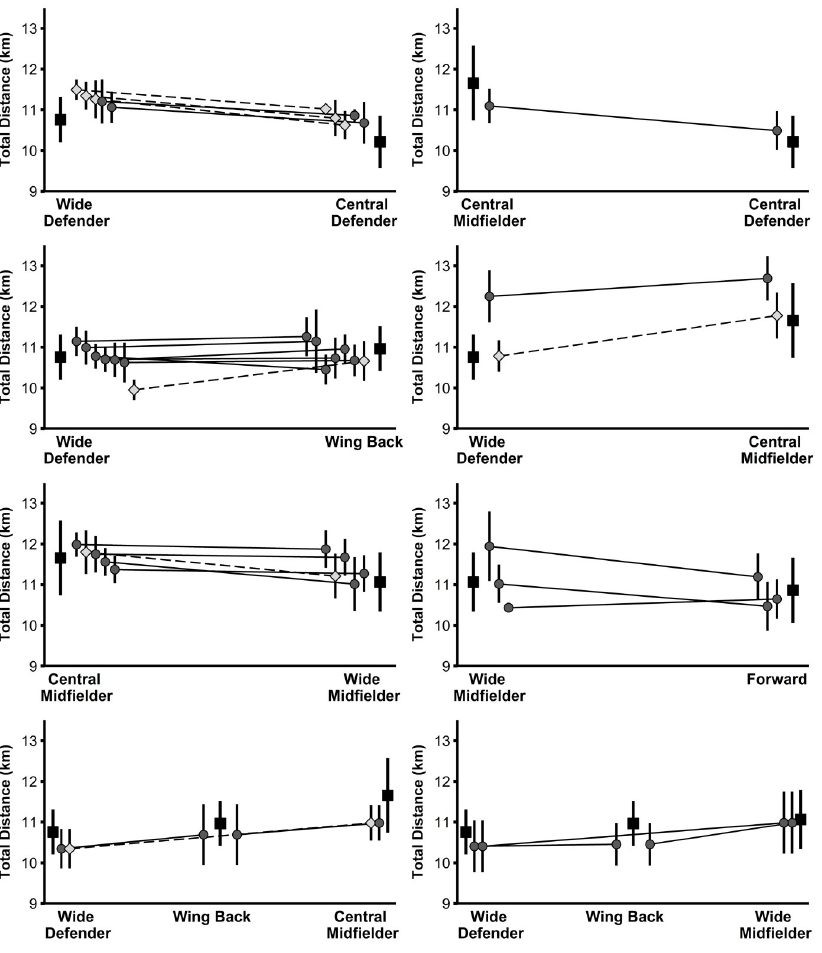
Fig 1. Total distance of players from the study sample (grey diamonds and circles) in relation to normative positional data (black squares). Data are presented as mean values ± SD. Light grey diamonds and dashed lines indicate significant differences in performance between the two positions for the respective